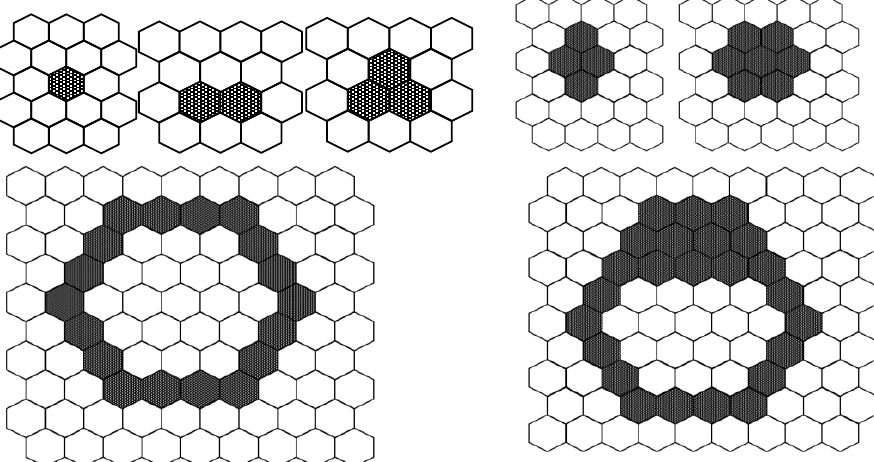
Figure 7. Initial conditions of hexagonal grids field. The black cell indicates the 1 state and the white cell indicates the 0 state. These configurations of state 1s were set in the center of the calculation fields.